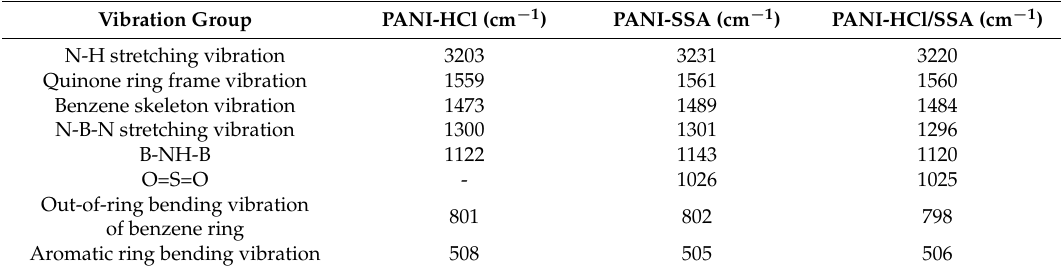
Table 1. FTIR characteristic peaks of different acid-deposited PANI.